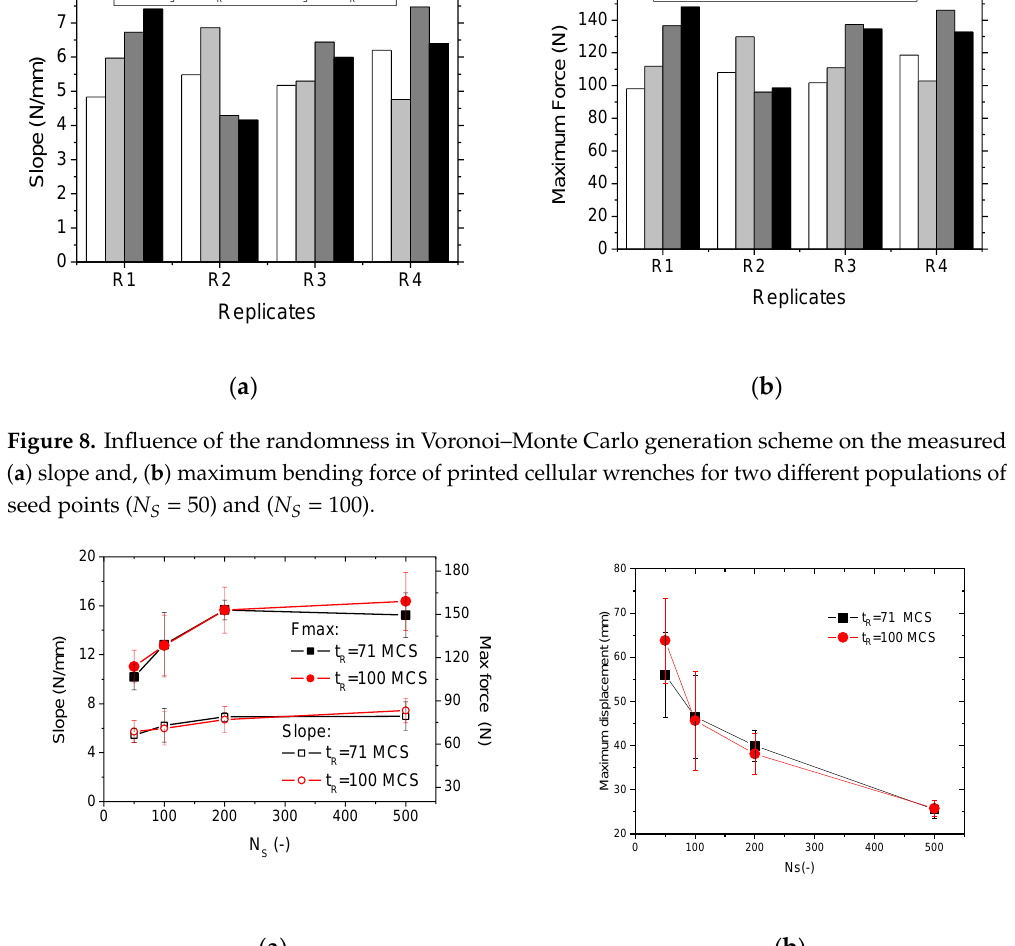
Figure 8. Influence of the randomness in Voronoi–Monte Carlo generation scheme on the measured ( a ) slope and, ( b ) maximum bending force of printed cellular wrenches for two different populations of seed points ( 𝑁 𝑠 = 50) and ( 𝑁 𝑠 = 100).